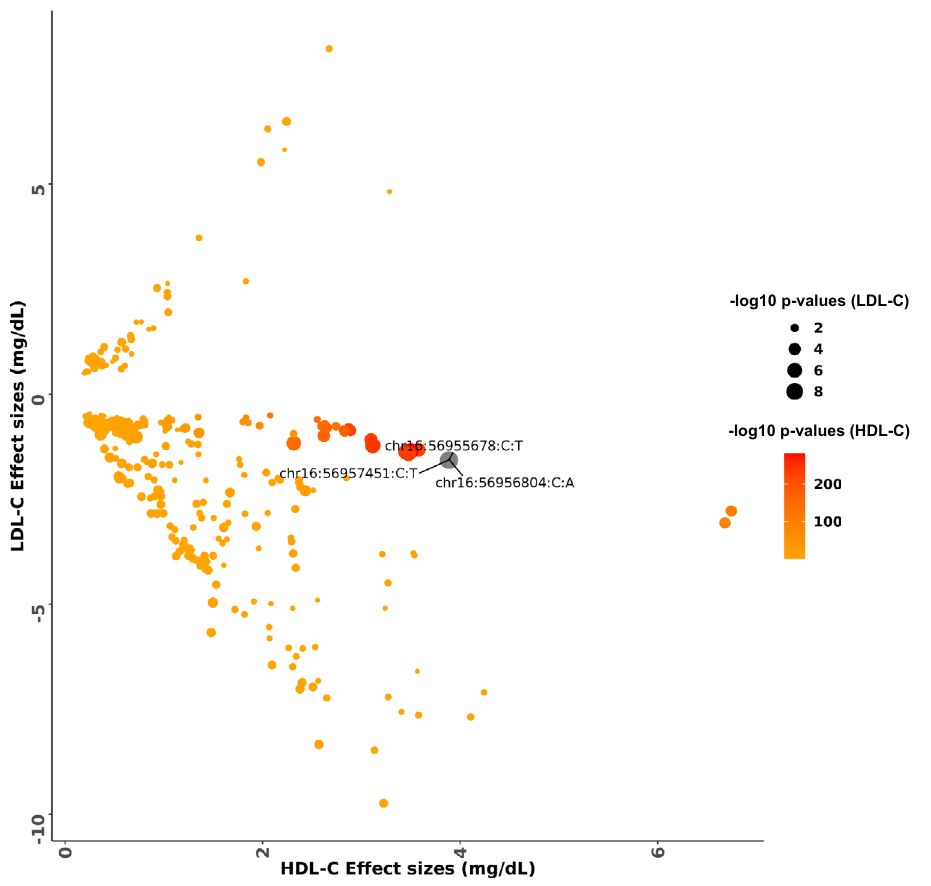
Fig.3|ComparisonofeffectsestimatesforHDL-CandLDL-Camongvariantsin the CETP locus. The color scale of the data points was based on − log10 p -values from HDL-C association and the size of each data point was based on − log10 p -values of LDL-C association. Variants which are genome wide signi fi cant with LDL-C are represented as chromosome:position:reference allele:alternate